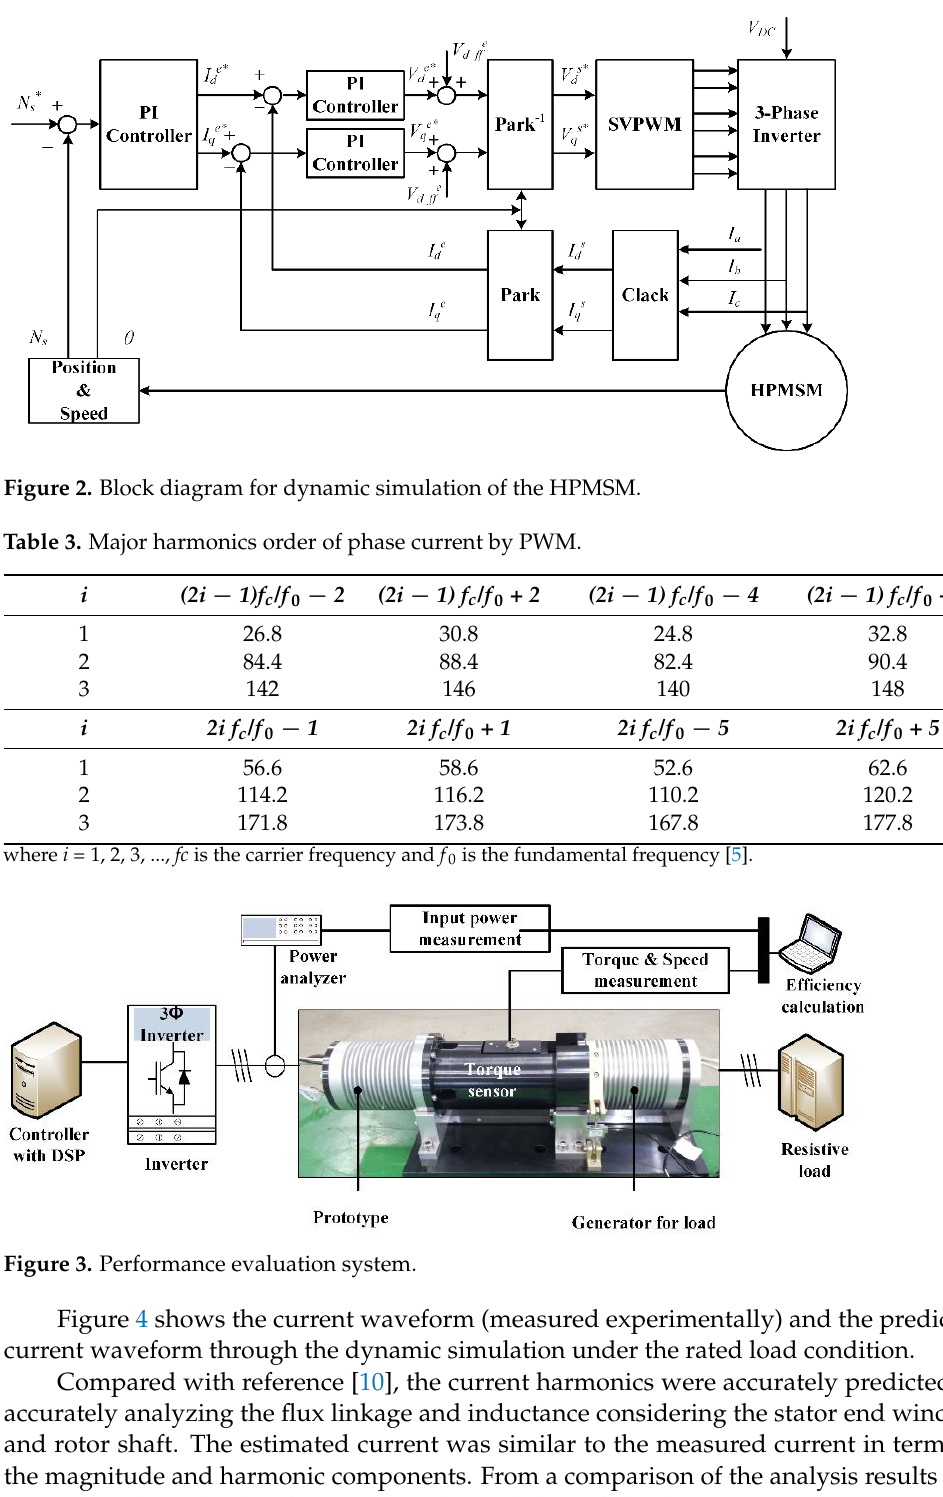
Figure 3. Performance evaluation system.